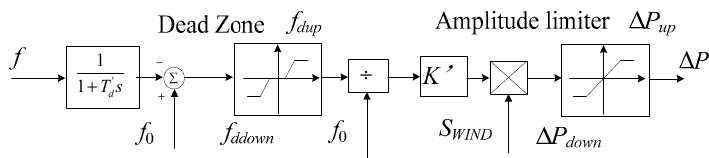
Figure 6. Primary frequency regulation (PFR) control diagram.